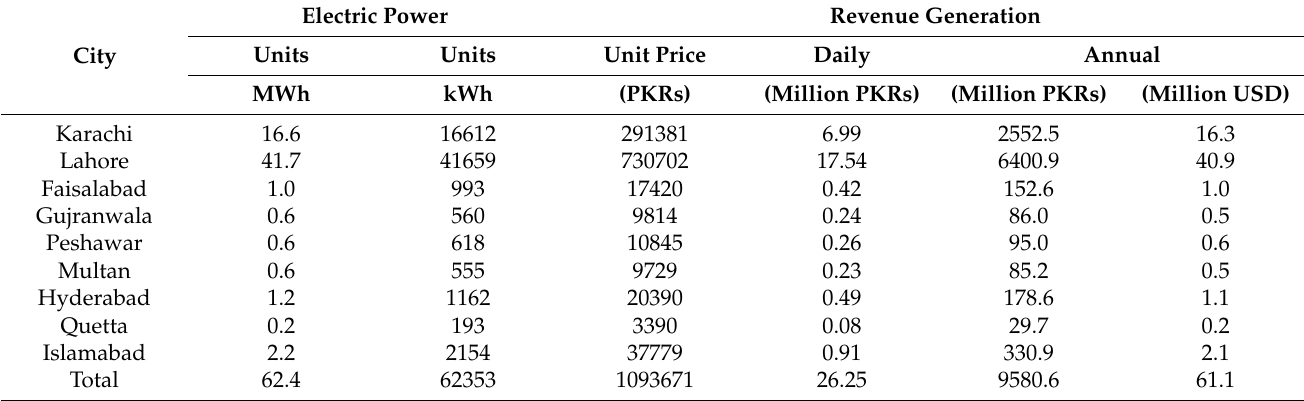
Table 10. Detailed calculations for financial benefits from selling the electric power generated at 25% CH 4 recovery rate.